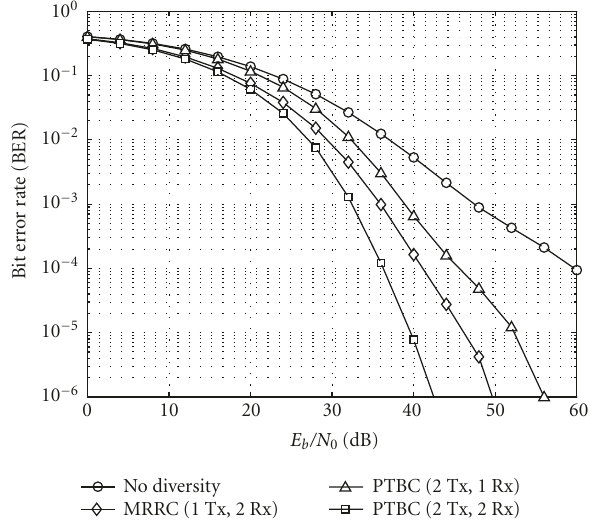
Figure 4: Bit error rate curves for highway